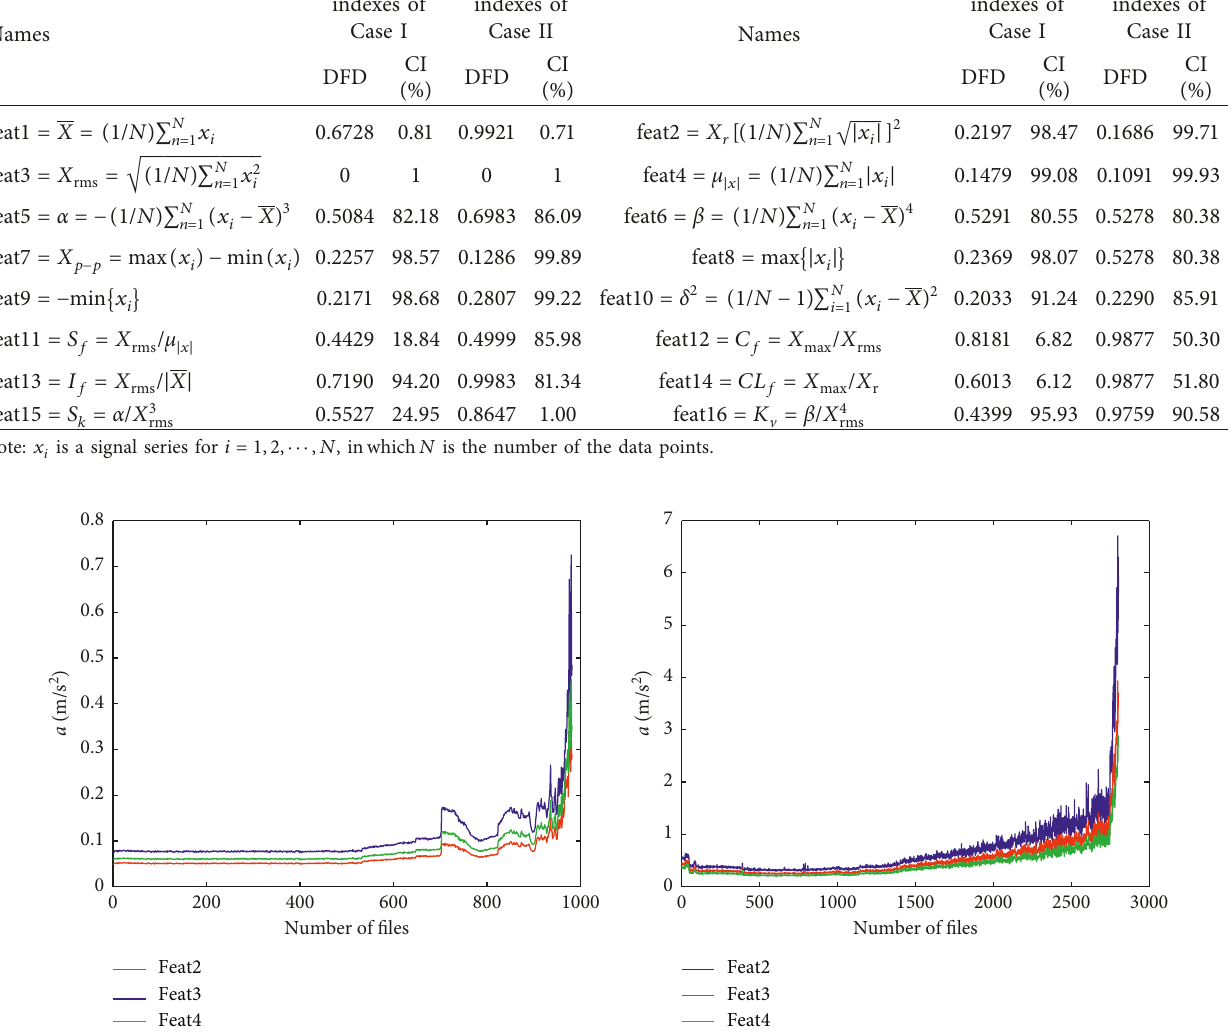
X , and μ | x | of the whole life of (a) Case I and (b) Case II. r , rms